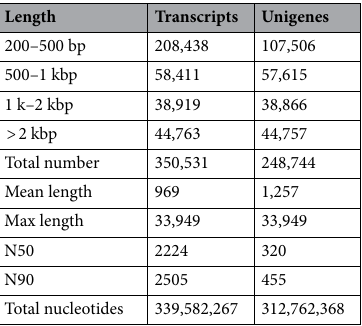
Table 1. Scylla paramamosain transcriptome